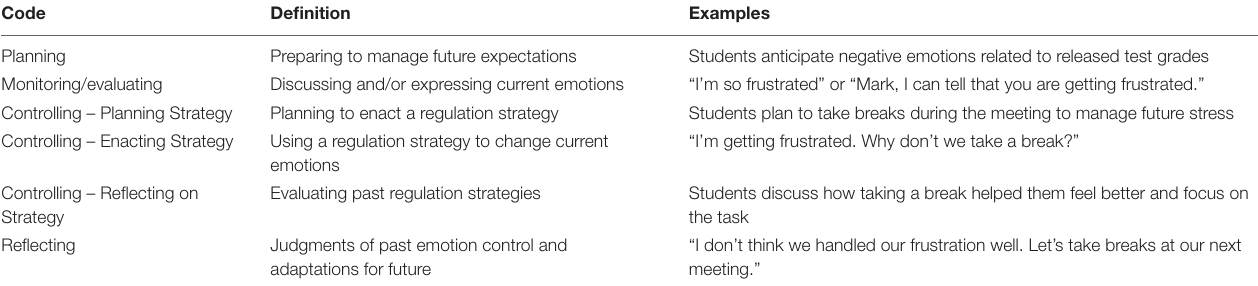
TABLE 6 | Regulation codes—phase.